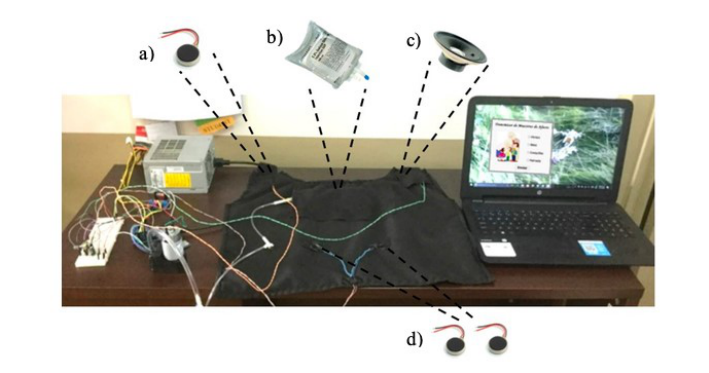
Figure 1. First AffectiVest prototype; ( a ) tap representation; ( b ) hug representation; ( c ) kiss representation; ( d ) tickle